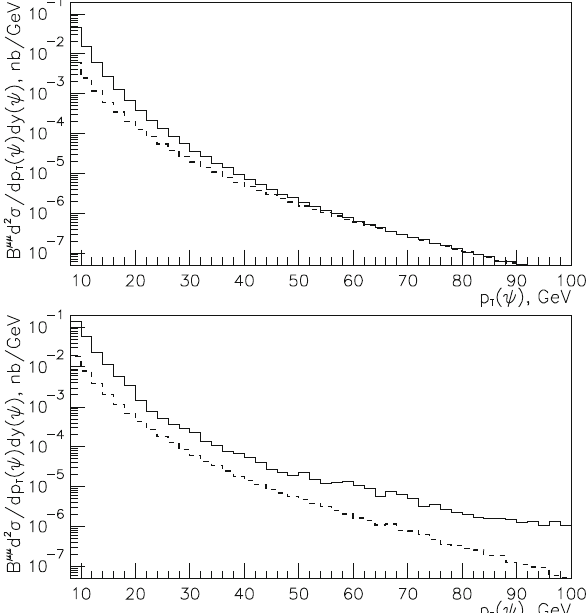
Fig. 7 Transverse momentum distributions of J /ψ mesons produced √ s = 7 TeV. The full O (α 4 s ) at the mid rapidity in pp collisions at calculation g g → ψ c ¯ c is shown by solid curve. The fragmentation approximation, g g → c ¯ c , followed by c → ψ c with D c /ψ ( z ) from e + e − annihilation, is presented by dashed curve. Upper plot is calcu- lated within the collinear factorization scheme with the MSTW gluon densities [22]; lower plot, within the k t -factorization model with A0 gluon densities